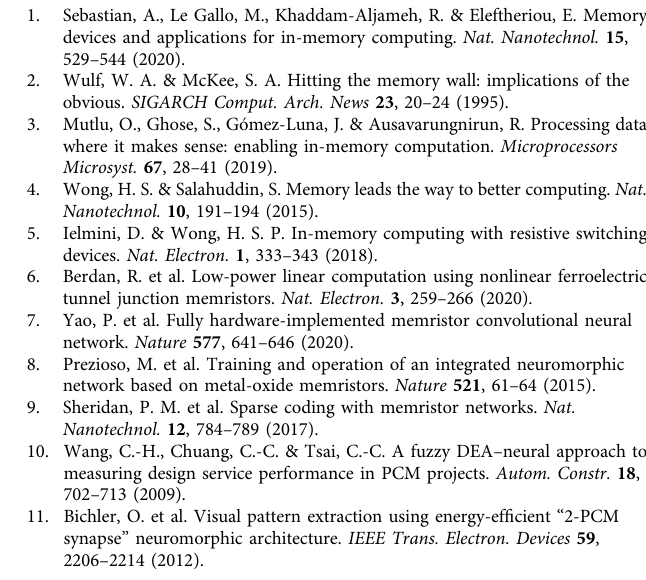
trained weights are re-quantized to 4-bits. The size of the colormap is 20 ×